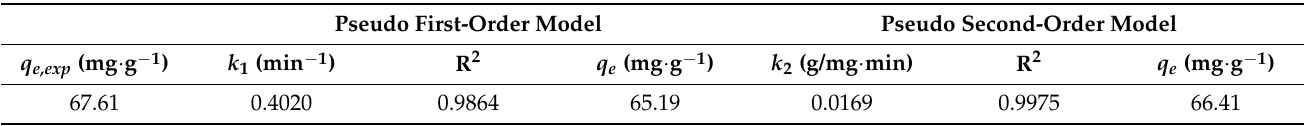
Table 1. Kinetic parameters for AC adsorption onto N-SC/ β